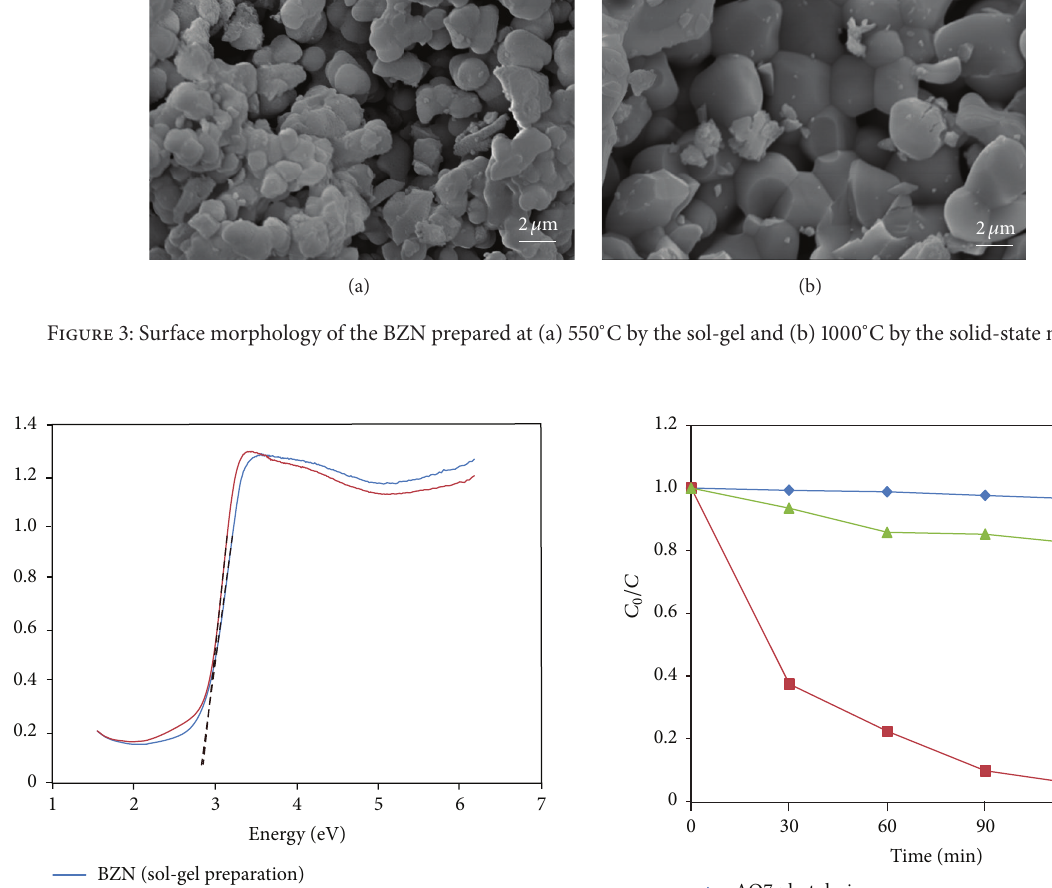
BZN (sol-gel preparation) BZN (solid-state preparation) Figure 4: Absorption edge of the BZN powders prepared at 550 ∘ C by the sol-gel and 1000 ∘ C by the solid-state methods.